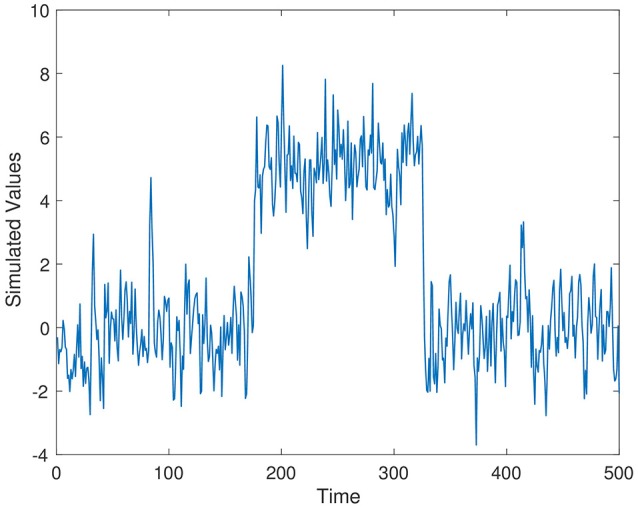
Simulation time series 2, ρ2 = 0.4.